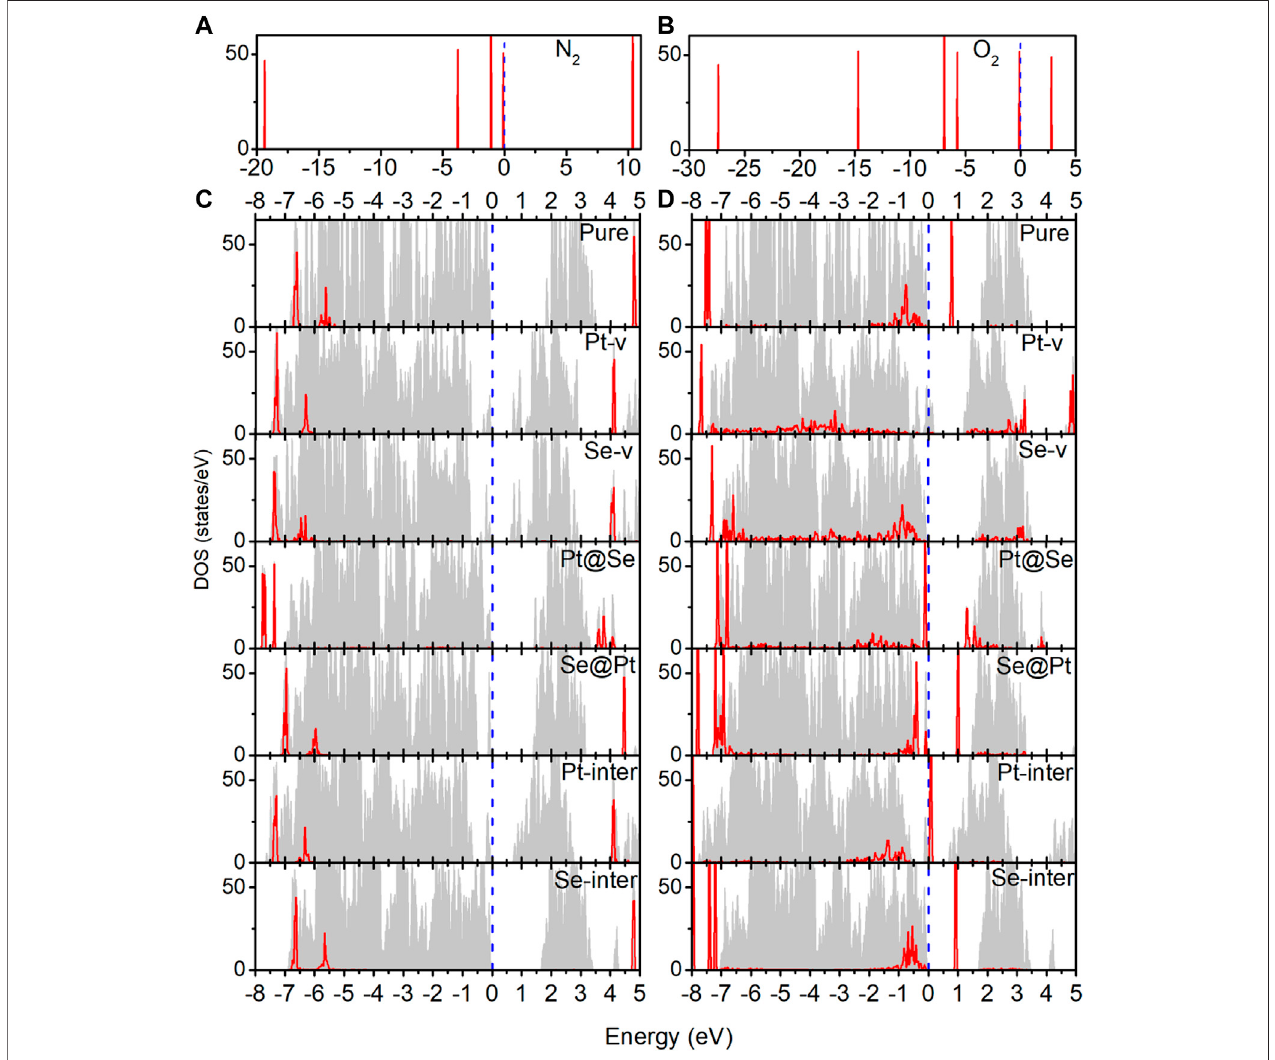
FIGURE3|(A) Densityofstates(DOS)oftheisolatedN 2 molecule. (B) DOSoftheisolatedO 2 molecule. (C) DOSofpureanddefectedPtSe 2 withtheadsorptionof N 2 . (D) DOSofpureanddefectedPtSe 2 withtheadsorptionofO 2 .ThegrayareasindicatetotalDOSofthecorrespondingstructures,andtheredlinesindicateprojected DOSoftheabsorbedmolecule.ThevaluesofDOSforadsorbedN 2 andO 2 onPtSe 2 aresetto1.5and4timesforclearcomparison.TheFermilevels(blue-dashedlines) for all the structures are set to 0